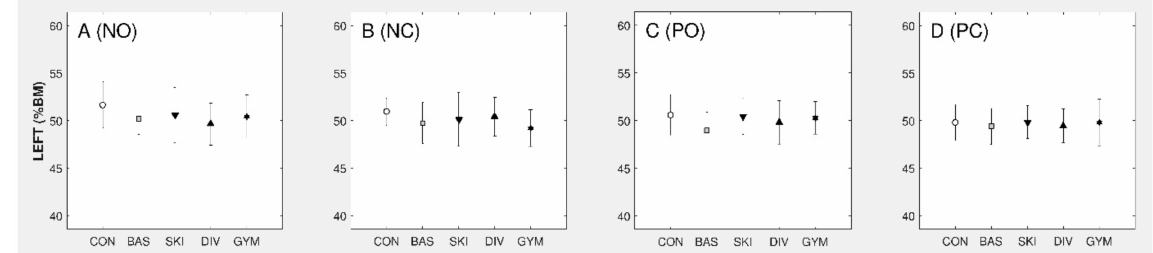
Figure 5. Parameter medio-lateral load distribution (LEFT) for different sports in positions in positions NO ( A ), NC ( B ), PO ( C ), and PC ( D ). CON—recreational athletes, BAS—Basketball, SKI—Ski Jumping, DIV—Diving, GYM—Gymnastics. Values are given as mean and standard deviation.